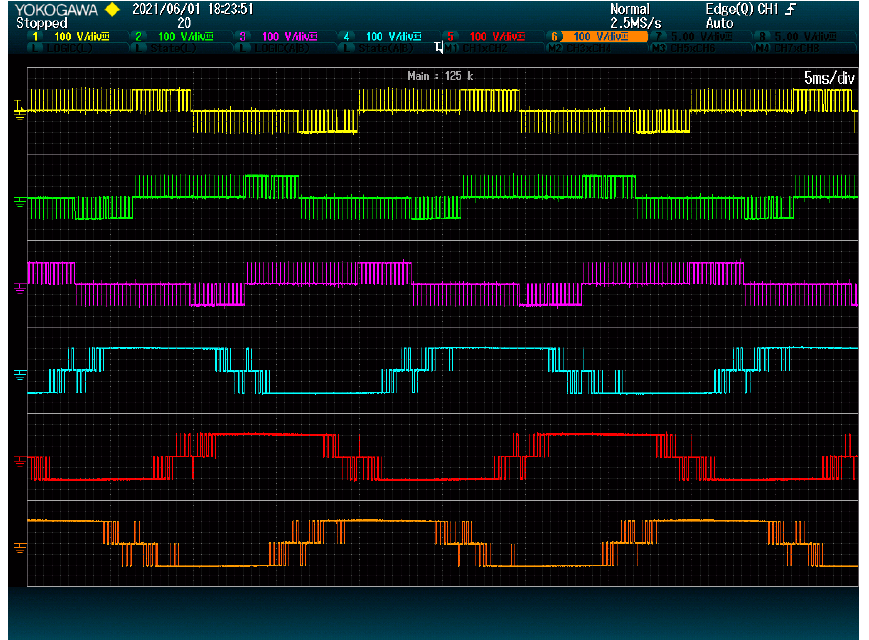
Figure 12. Modules switching when reducing ripple. 2.5 grid periods are shown.